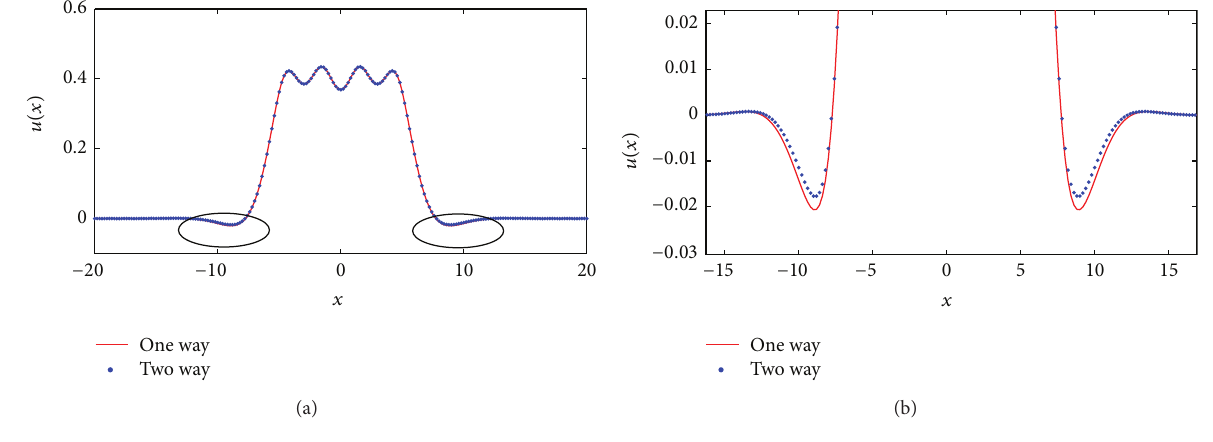
Figure 13: Validity of the solution in Figure